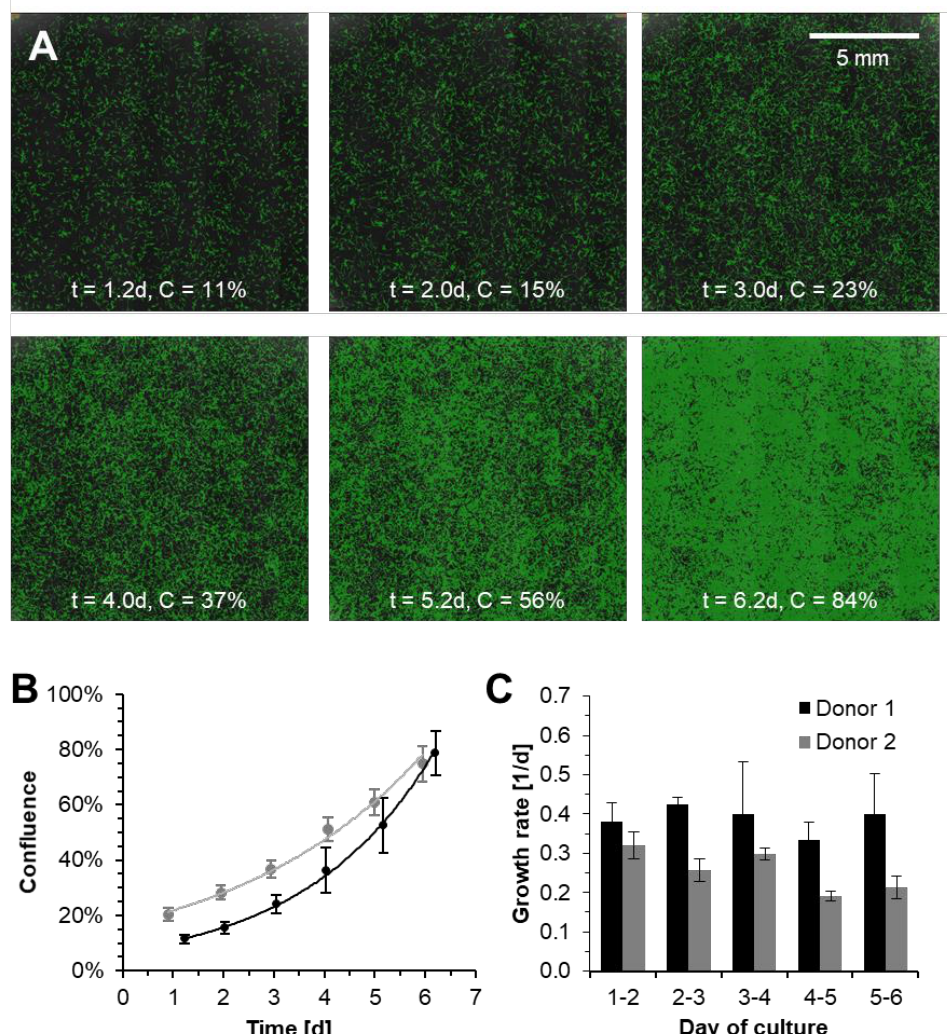
Figure 7. ( A ) Overlay of the microscopic images taken daily from the second well (A2) of the six–well plate in a culture of cells from donor 2. ( B ) Confluences in the cultures of cells from two donors over the course of six days. Given is the average confluence across all six wells of the plate (dots) and the exponential regression curve (solid line). The error bars indicate the standard deviation of the confluence across all six wells. ( C ) Daily growth rates in the cultures of cells from two donors over the course of six days. Growth rates were calculated well–wise, and the average was calculated across all six wells. The error bas indicates the standard deviation of the growth rate across all six wells.